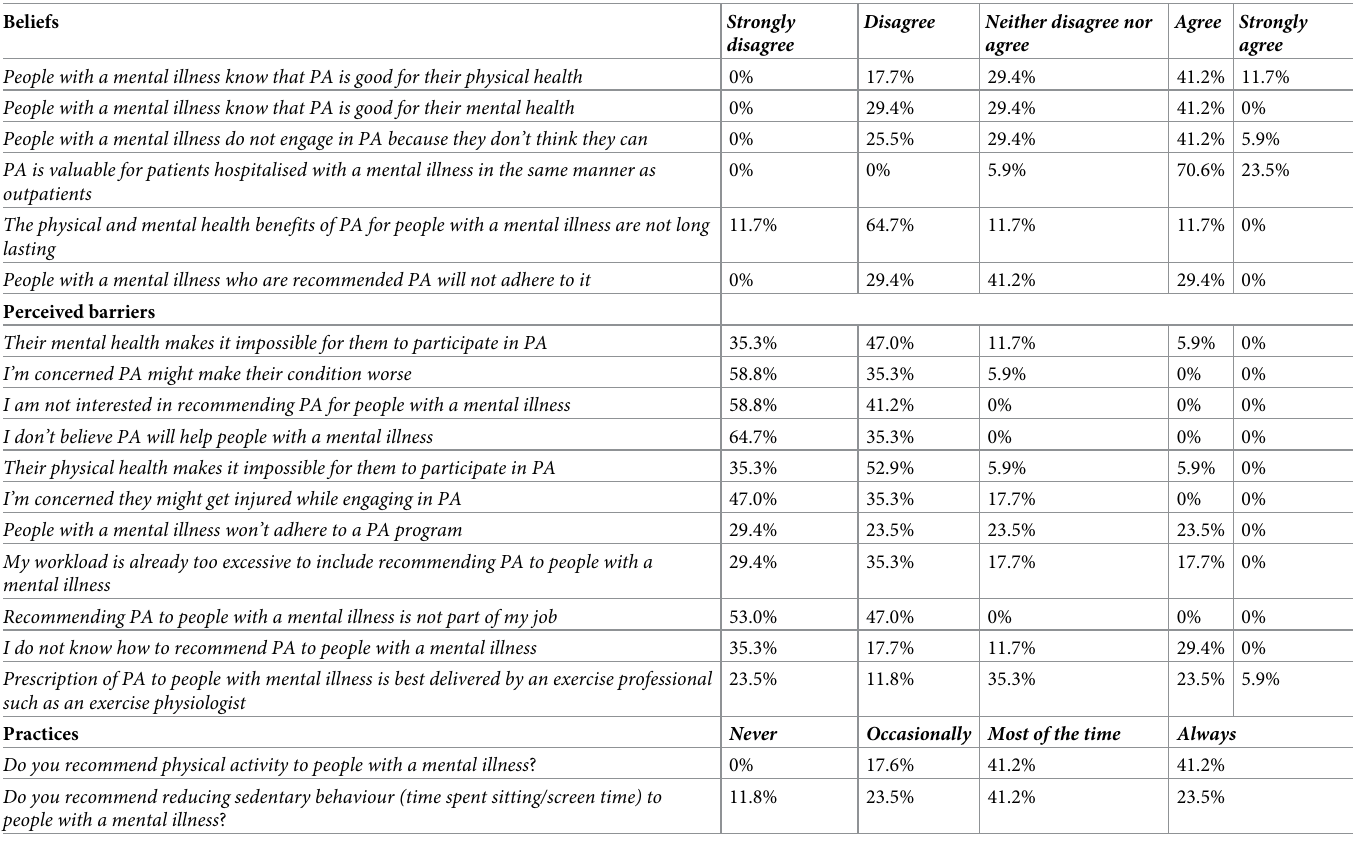
Table 3. Attitudes and practices of mental health professionals in recommending more PA and less SB to their clients. Beliefs Strongly